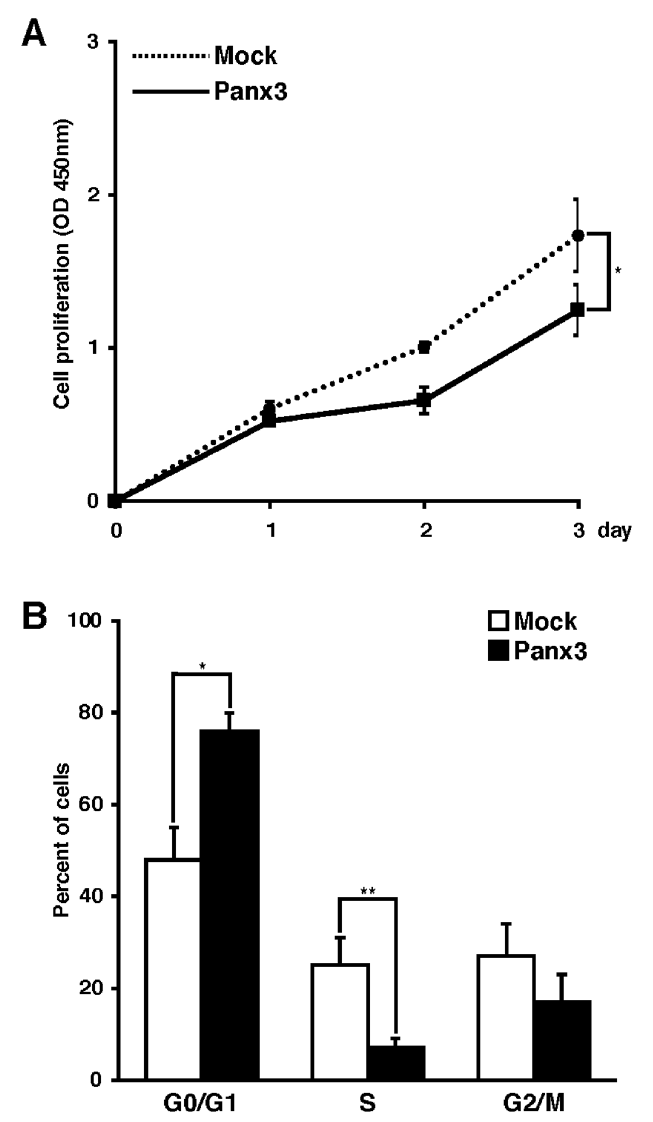
Figure 4. Panx3 promotes cell cycle exit in HaCaT cell proliferation. ( A ) pCMV6-mock or pCMV6-Panx3 were transiently transfected HaCaT cells were cultured in normal condition media for the indicated days. * p < 0.01. Error bars represent the mean ± SD; N = 3. ( B ) FACS analysis of cell cycle on pCMV6-mock or pCMV6-Panx3 transiently transfected HaCaT cells cultured in normal condition media for 3 days. The cells were stained with propidium iodide, and cell cycle stages were measured by FACS analysis. The panels represent distribution of cells (%) in the G0/G1, S, and G2/M phases. ** p < 0.05, * p < 0.01. Error bars represent the mean ± SD; N =